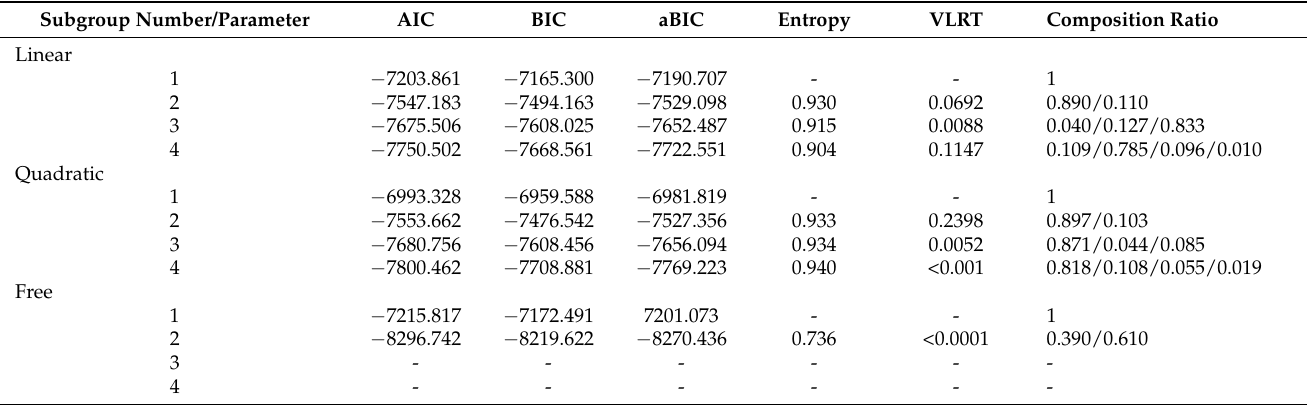
Table A3. GMM fitting statistics results (prenatal